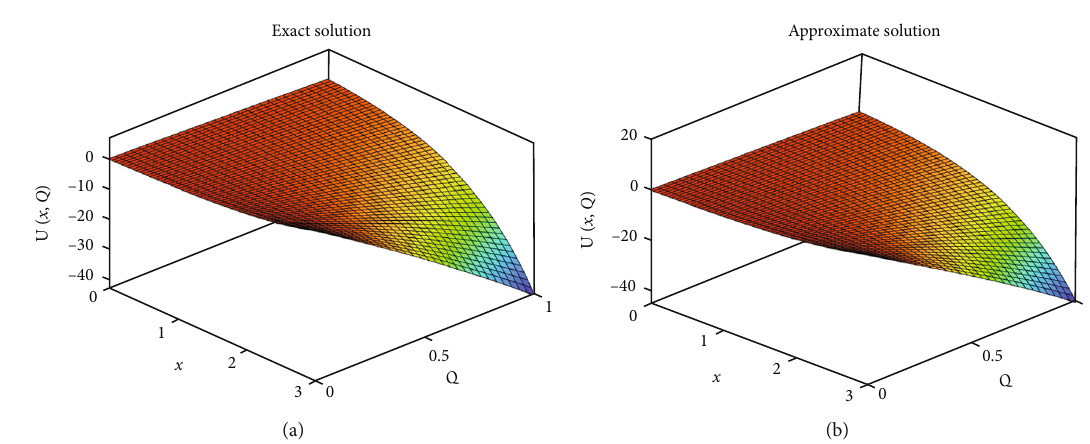
Figure 1: Three-dimensional illustration via CFD of Example 1 when δ = 1 . (a) Exact solution. (b) Approximate solution.